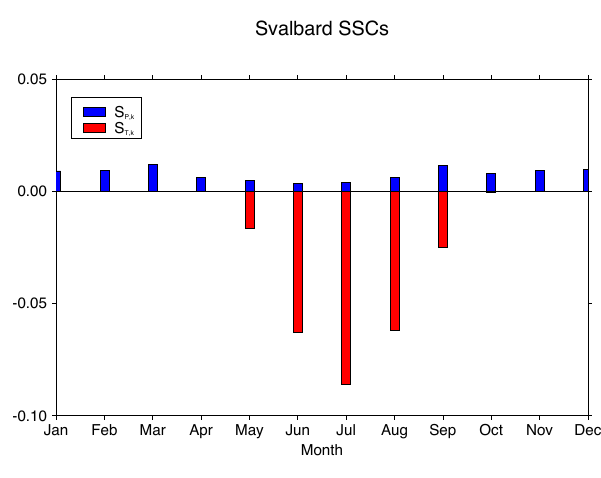
Fig. 2. Seasonal sensitivity characteristics (SSCs) for Svalbard re- produced from Oerlemans et al. (2005). These were averaged from the SSCs of a number of glaciers in